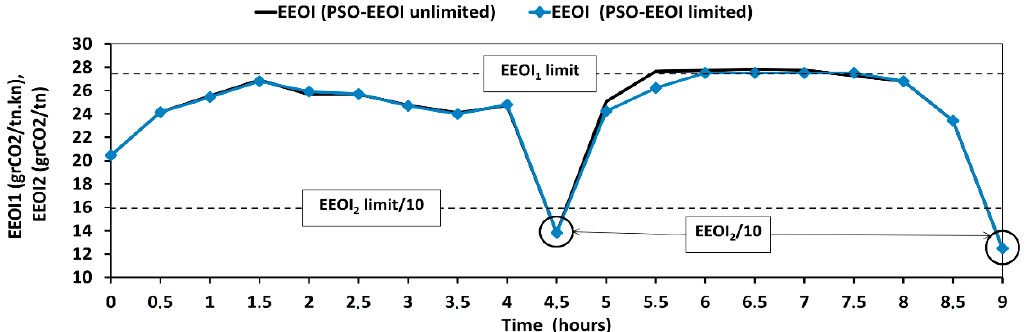
Figure 12. Ship energy efficiency operation index: PSO with/without limitation.